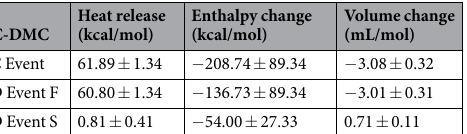
and unlabeled V5C using the equation: chemical yield = ∆ V observed / ∆ V theoretical . As calculated using Chimera with solvent probes of 1.4 Å radius, the volume gain of V5C-DMC would be 178.8 Å 3 per molecule (Fig. 3d). With the observed overall volume change of − 2.34 mL/mole ( − 3.05 mL/mole, which is the average of PAC and fast PBD event, plus 0.71 mL/mole in the slow PBD event), which corresponds to 3.89 Å 3 per molecule, the chemical yield of cage release is ~2.2%, which is about 10 times smaller than the cleavage quantum yield measured for the DMC-labeled peptide in our previous study 29 . Once we obtained the chemical yield, we were then able to calculate the thermal release of DMC upon photon excitation and the enthalpy change of proteins. Based on the energy conservation theory and fluorescence quantum yield (see Supplementary Fig. S4), the enthalpy was